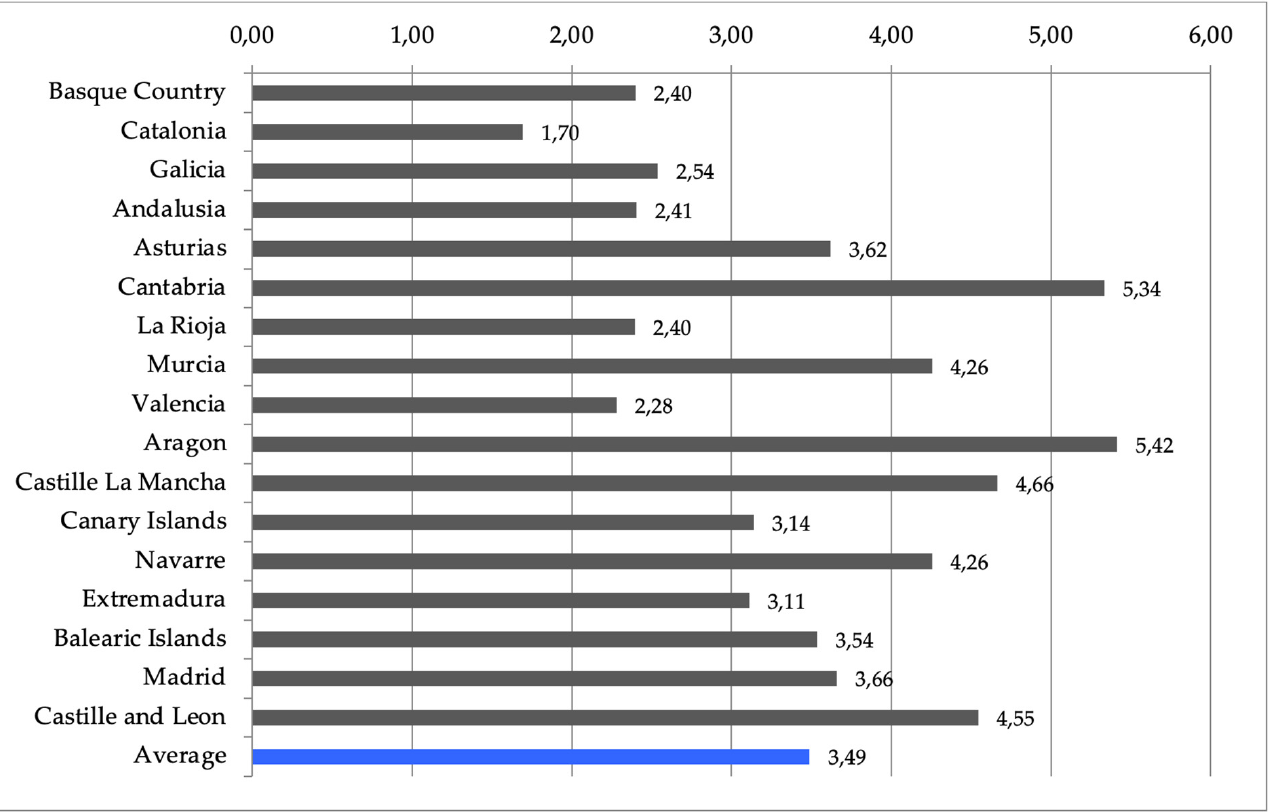
Figure 3. Transparency and ease of access to contents in the analysed regions.